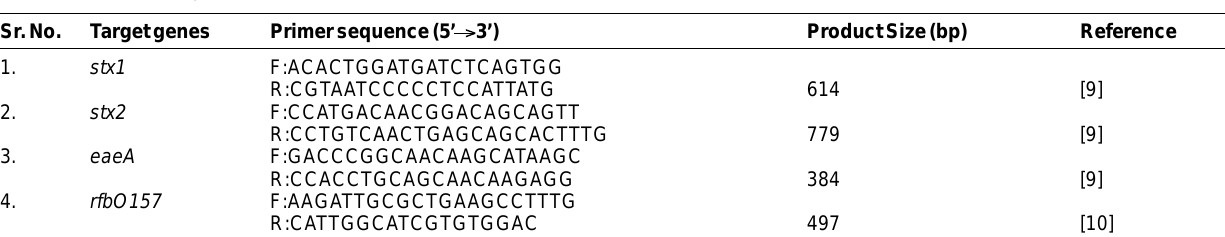
Table-1. Details of primers used for PCR